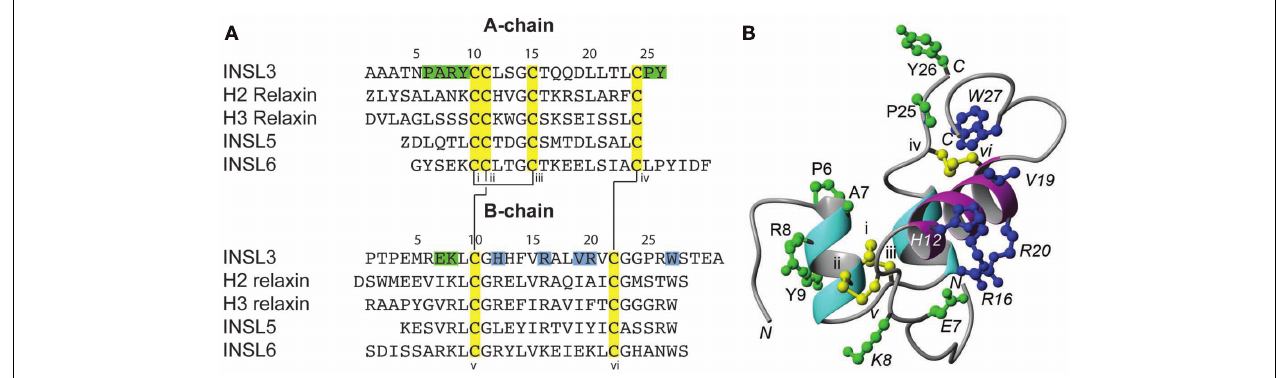
bonds are shown in ball-and-stick representation and are highlighted in yellow in both panels and numbered sequentially by roman numbers.The disulfide connectivity is illustrated by connecting lines in (A) . Residues in the B-chain that have been shown to be important for receptor binding are highlighted in blue and additional residues whose potential roles in the activation of INSL3 are discussed throughout this paper are highlighted in